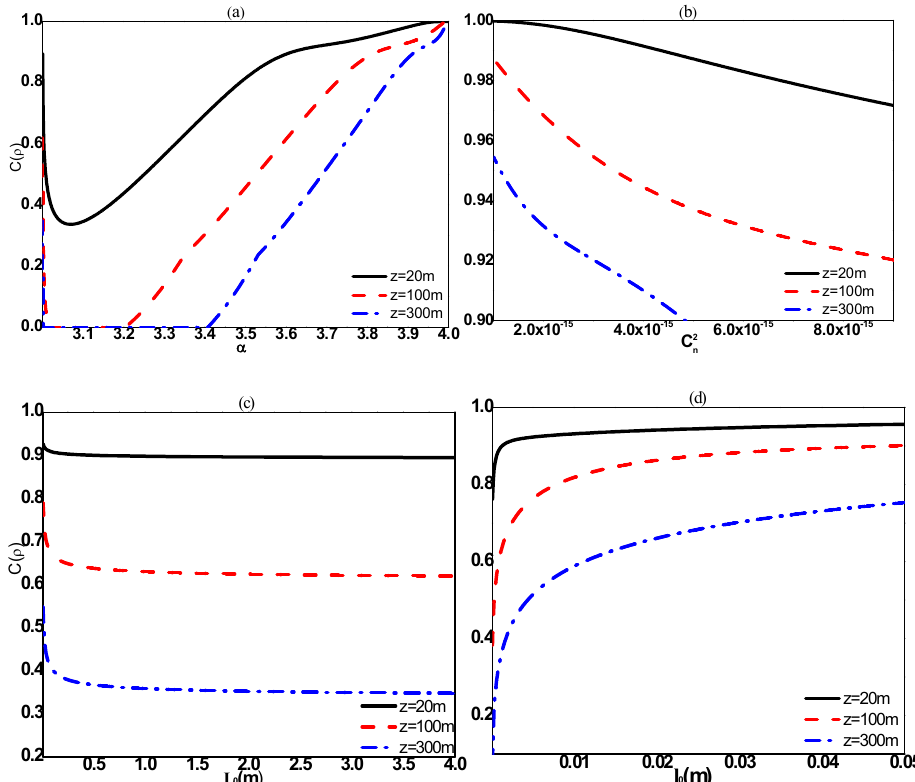
Figure 5. Concurrence plotted as the turbulence parameters for different propagation distances ( a ) of generalized exponent, ( b ) of refractive-index structure parameter, ( c ) of turbulence outer scale, and ( d ) of turbulence inner scale.